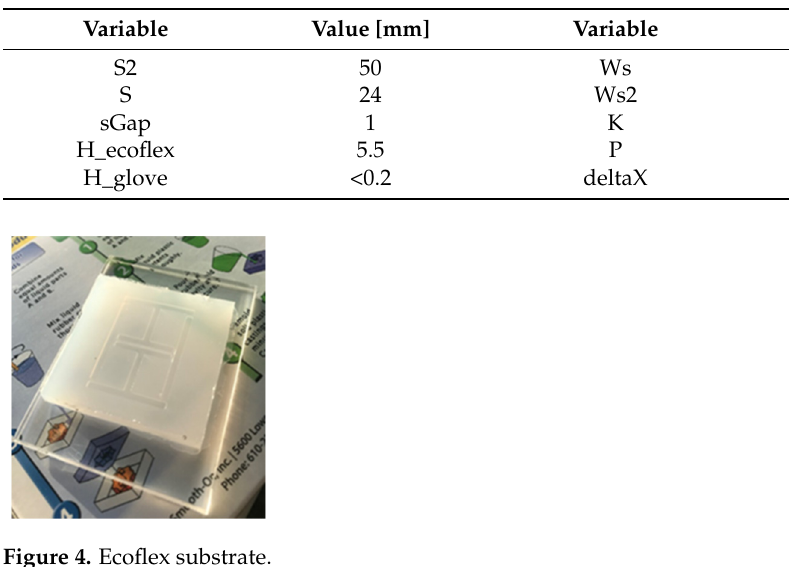
Figure 5. EDM latex tag on copper sheet.